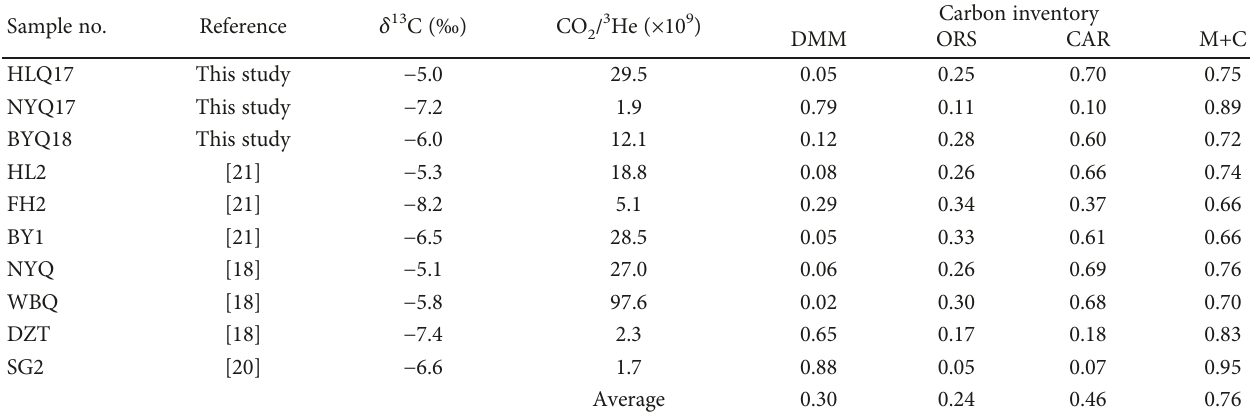
Table 2: Estimated carbon sources for the spring gas samples in WMVF. Sample